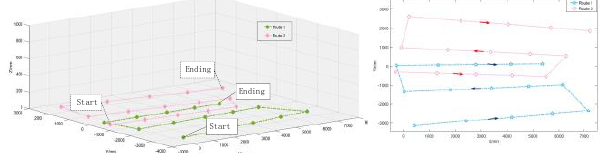
Figure 7 . Relative acquisition line of the collector.